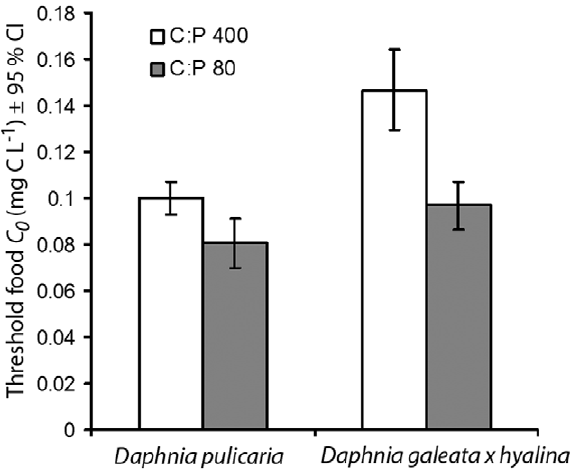
Figure 4. Threshold food concentrations ( C 0 ± 95% CI) support- ing zero specific growth rates of 4-day-old D.pulicaria and D. galeataxhyalina cultured on P-poor (C:P 400, open bars) and P- rich (C:P 80; filled bars) algal food. C 0 values are parameter estimates from the Monod model.